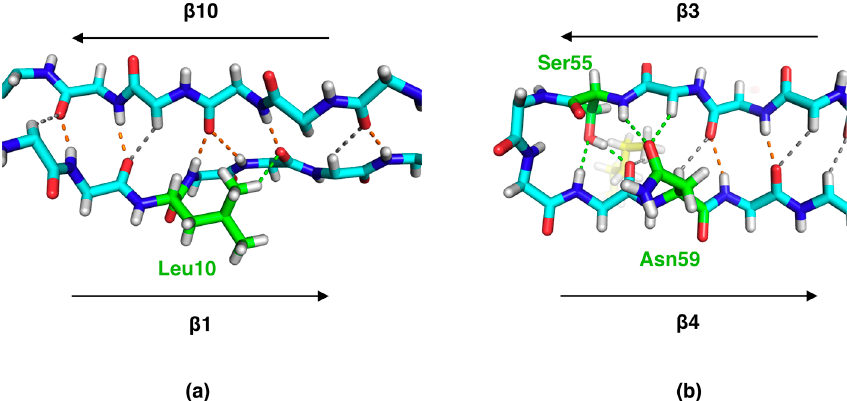
Figure 2. Examples of side chain involvement in β sheet hydrogen bonding. ( a ) A bump in strand β 1 is observed around residue 11. A closer inspection reveals a breakdown of β sheet structure, with two NH groups H-bonding to a single carbonyl moiety and the side chain of Leu10 providing a C-H...O bond to the carbonyl group of residue 12. ( b ) Near the β 3- β 4 loop, which is part of the portal region and predicted to open upon ligand exchange / membrane binding, the interactions near the loop involve side chains and the fatty acid ligand (yellow), although the backbone remains in an extended β conformation. Regular hydrogen bonds are shown in orange, main-chain C-H ... O bonds in gray, and bonds involving side chains in green. Only side chains participating in main-chain hydrogen bonding are visible (green).